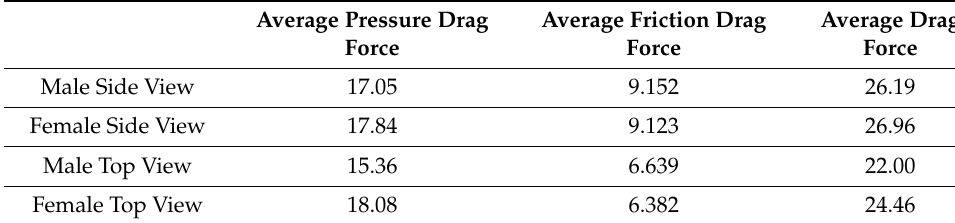
Table 4. Average Drag Forces of 2D Models.